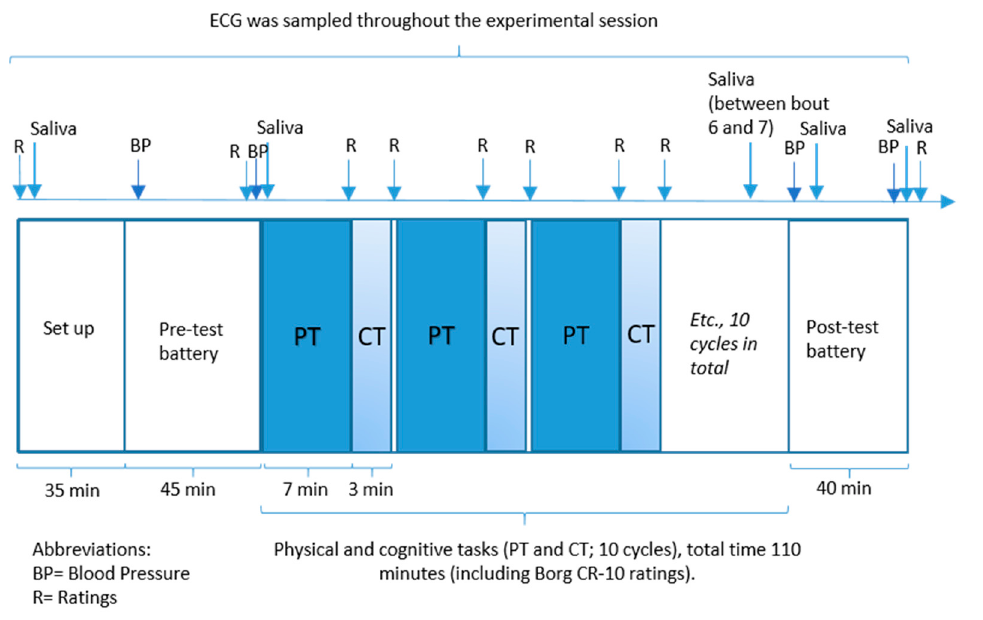
Figure 1. Flow chart for the experimental session. Total session duration was approximately four hours. ECG: Electrocardiography